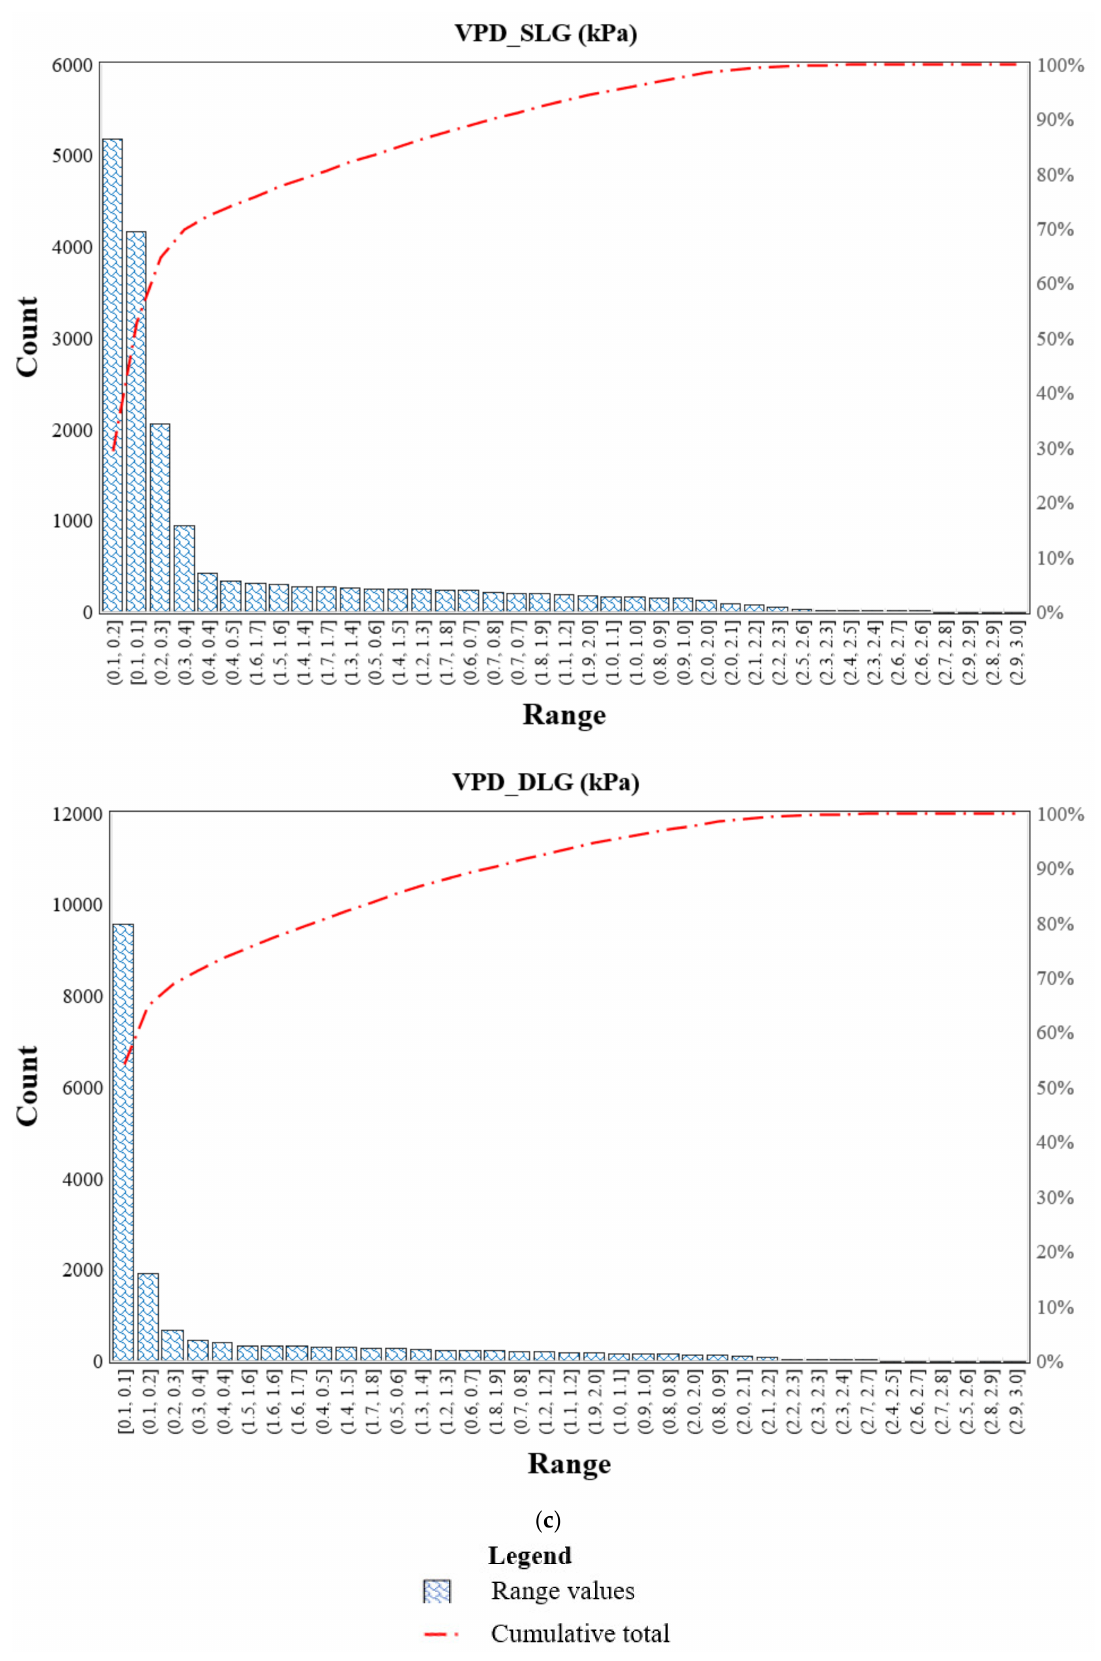
Figure 6. Pareto chart showing data spread of microclimate parameters T ( a ), RH ( b ) and VPD ( c ) in SLG and